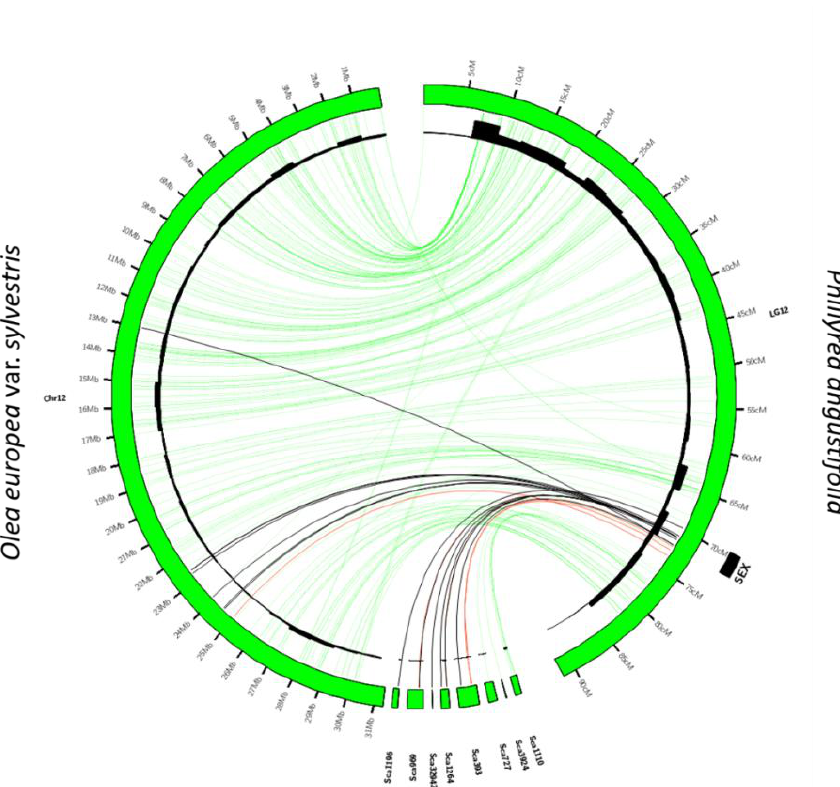
Figure 4. Synteny plot between the P. angustifolia linkage group 12 (scale in cM) and the olive tree chromosomes 12 and a series of unanchored scaffolds (scale in Mb). Lines connect markers in the P. angustifolia linkage map with their best BLAST hit in the O. europea genome. Green lines correspond to markers with autosomal inheritance. Black lines correspond to markers which strictly cosegregate with sex phenotypes (males vs. hermaphrodites). Red lines correspond to markers with strong but partial (95%) association with sex. Variation of the density of loci in bins of 3.125cM along linkage groups and 1 Mbp along chromosomes is shown in the inner circle as a black histogram